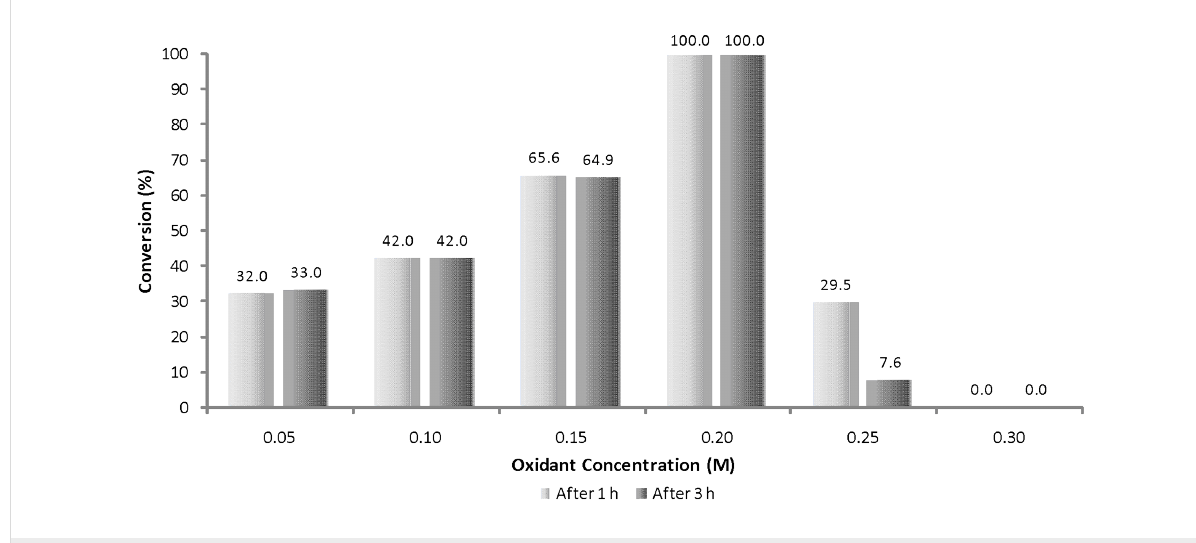
Figure 4: Graph illustrating the effect of oxidant stoichiometry on the conversion of 1-methylcyclohexene ( 6 ) to 1-methylcyclohexene oxide ( 7 ) at a residence time of 2.6 min (70 °C).